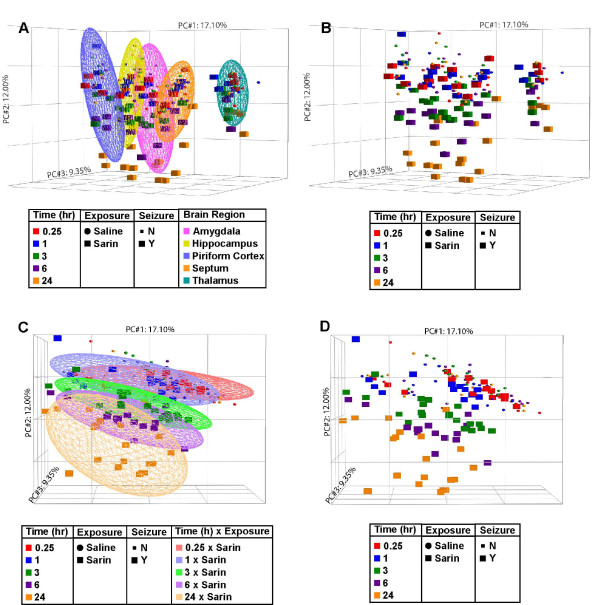
Principal component analysis reveals sample partitioning based on brain region and time following seizure onset. Rat amygdala, hippocampus, piriform cortex, septum, and thalamus were collected at the specified times after seizure onset and processed for oligonucleotide microarray analysis. The raw signal intensities were normalized using the RMA algorithm and visualized using PCA to identify major sources of variability in the data. Each point on the PCA represents the gene expression profile of an individual animal. Point shape corresponds to exposure condition, point color corresponds to the time after seizure onset at which the tissue was collected, and point size indicates absence or occurrence of sarin-induced seizure. Ellipsoids highlight partitioning of samples based on brain region (A) and time point following seizure onset at which the tissues were collected (C). The principal components in the three-dimensional graph represent the variability in gene expression levels seen within the dataset. Principal component 1 (PC#1, x-axis) accounts for 17.10% of the variability in the data; PC#2 (y-axis) represents 12.00% of the variability; and PC#3 (z-axis) represents 9.35% of the variability in gene expression levels seen within the dataset.